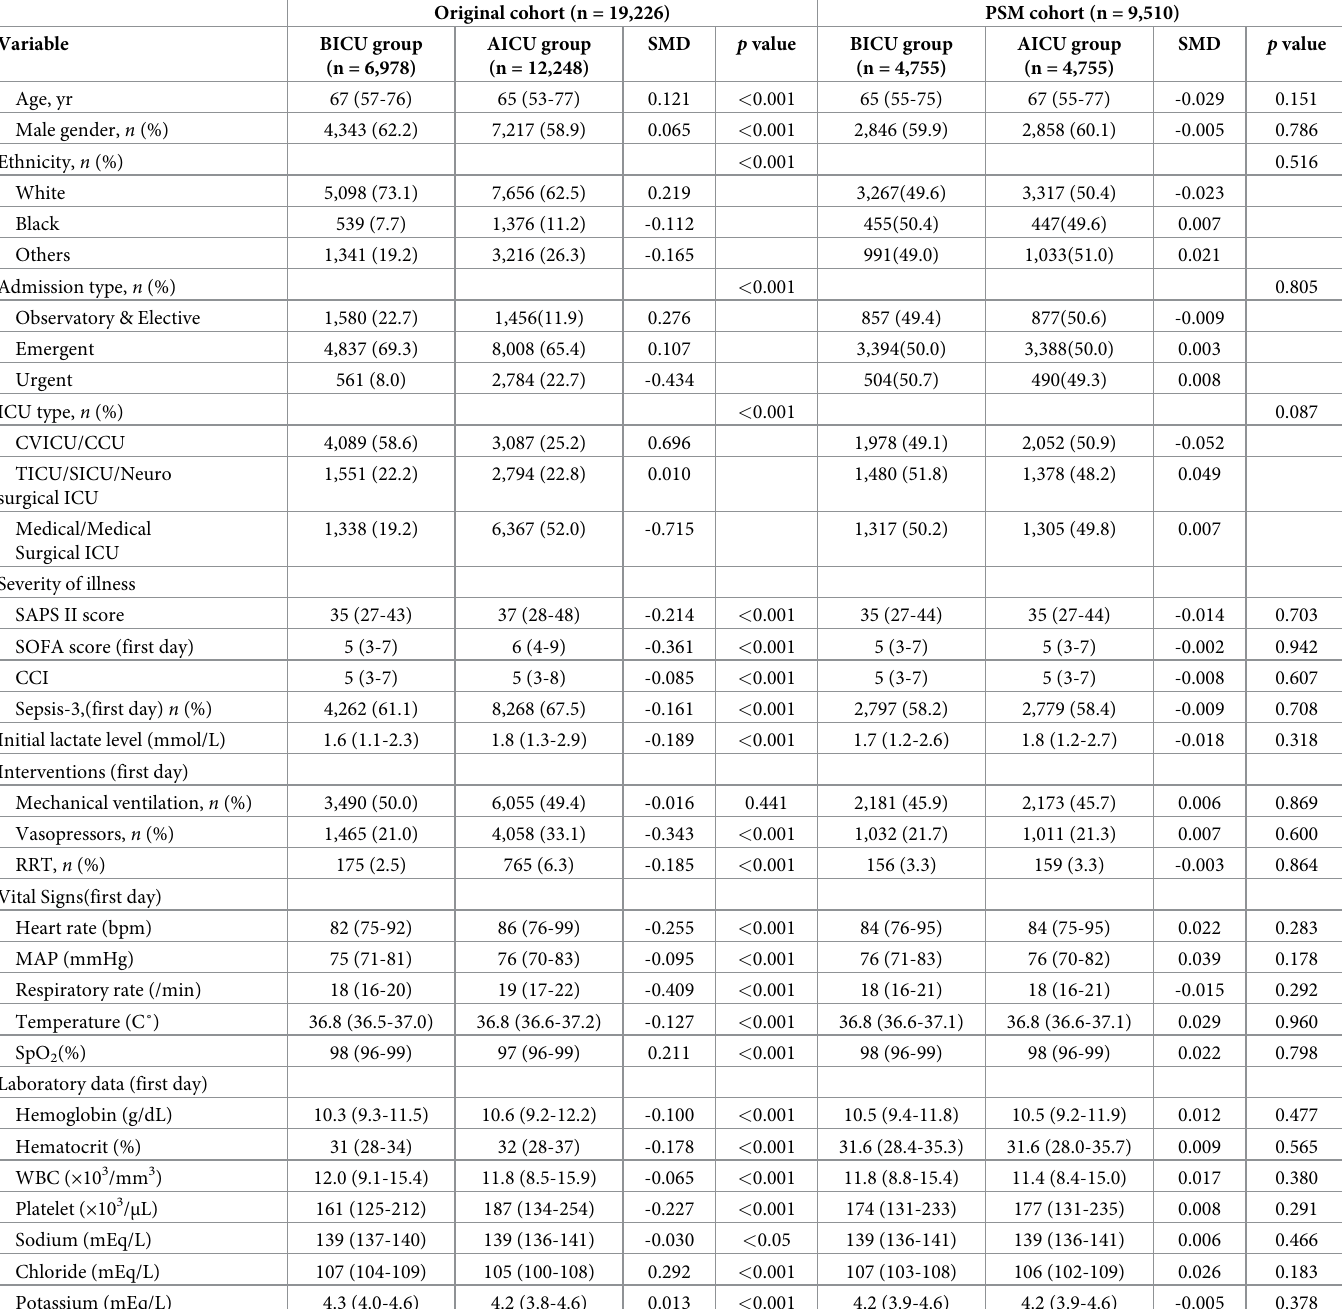
Table 1. Comparisons of baseline variable between BICU and AICU groups in original and PSM